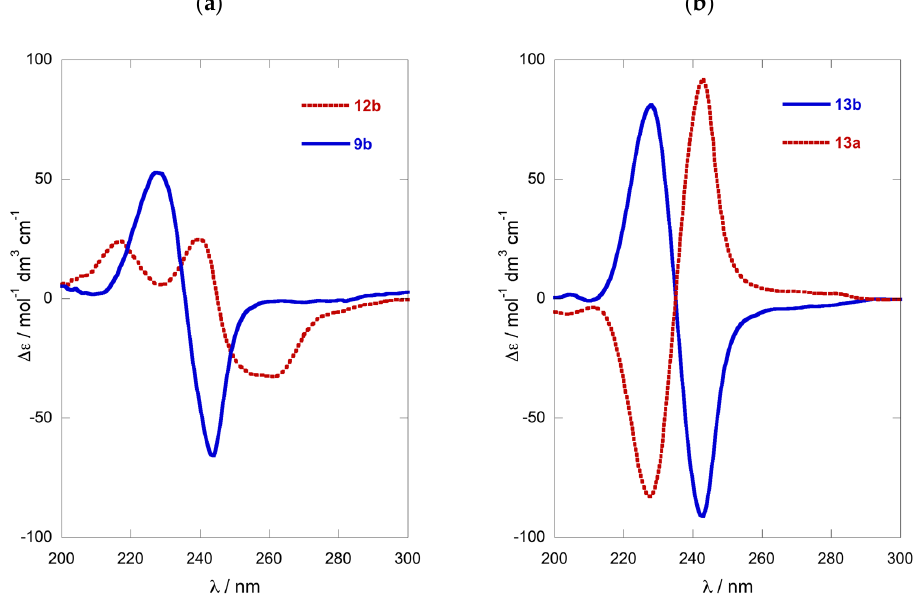
Figure 3. ECD spectra of: ( a ) ( R )- 9b ( –– ) and ( R )- 12b ( --- ) (TFE, 23 °C); and ( b ) ( S )- 13a (this work) and ( R )- 13b [12] (MeOH, 23 ˚C).